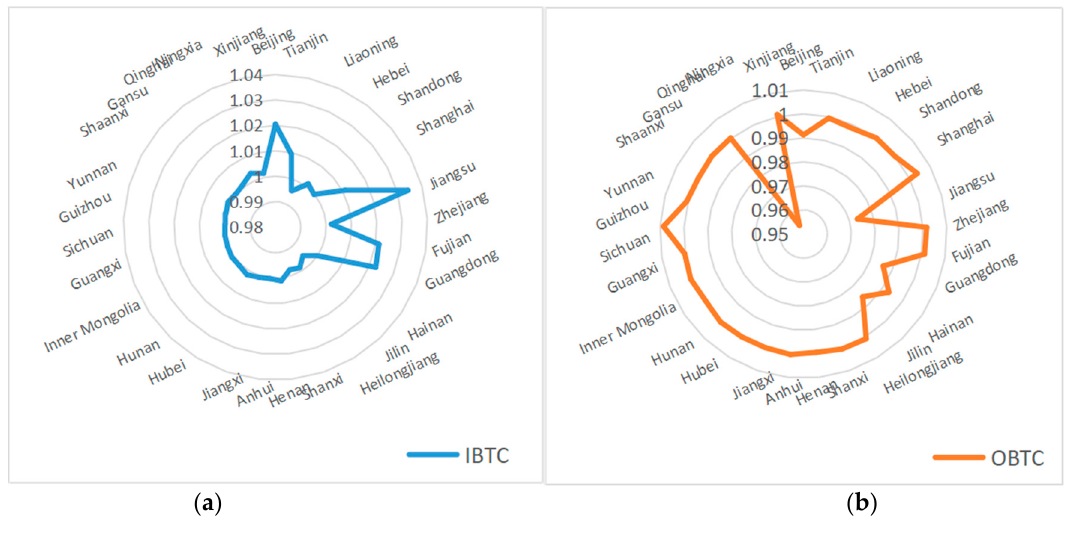
Figure 3. ( a ) Statistics of IBTC indexes of each province; ( b ) statistics of OBTC indexes of each province.